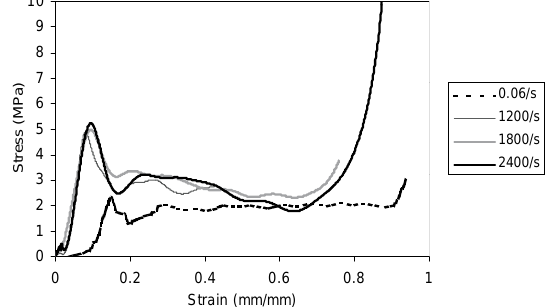
Fig.7. Lowrateout-of-plane stress-strain curves forACGAluminum honeycomb.